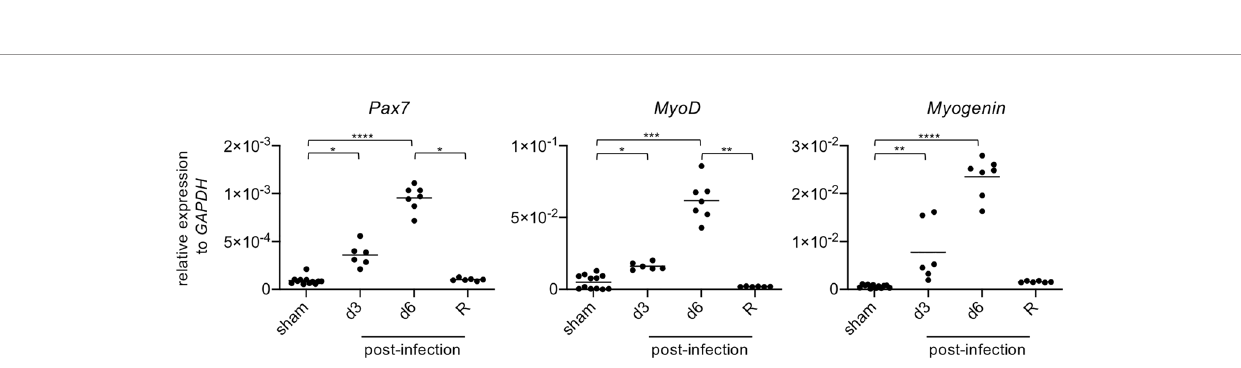
comparison test. * P < 0.05; ** P < 0.01; *** P < 0.001; **** P < 0.0001.